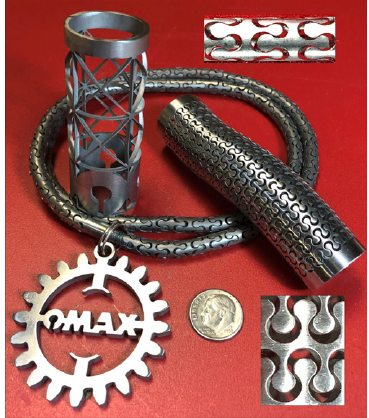
Figure 5: AWJ-cut parts with the use of the Rotary